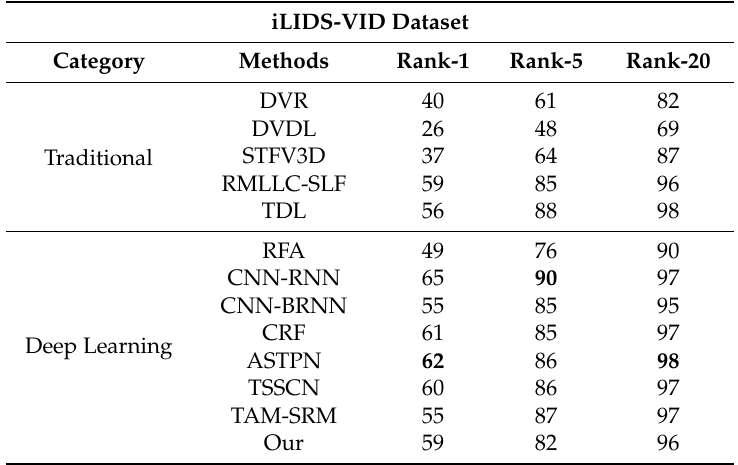
Table 4. Comparison experiment with two types of state-of-the-art algorithms for theiLIDS-VID dataset in terms of CMC